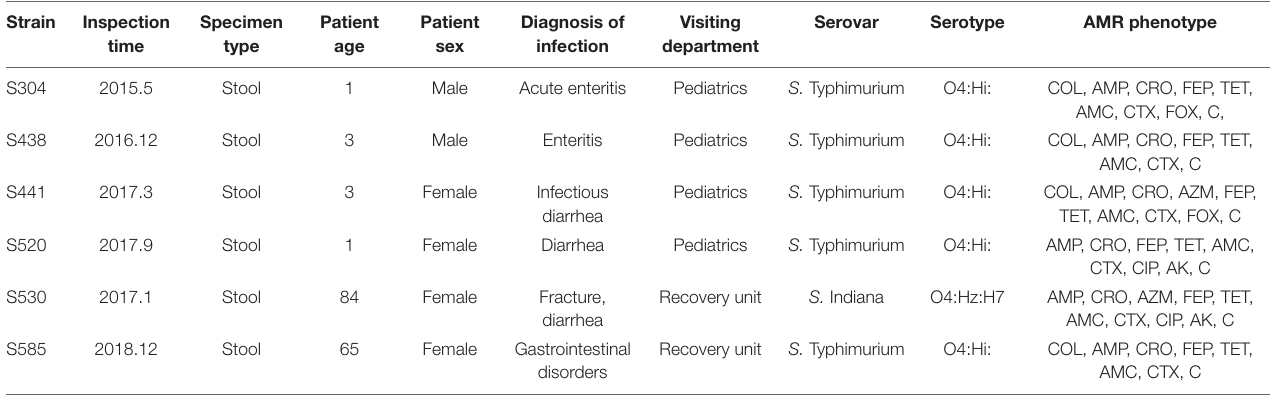
TABLE 2 | Basic situation of mcr-1 positive strains.